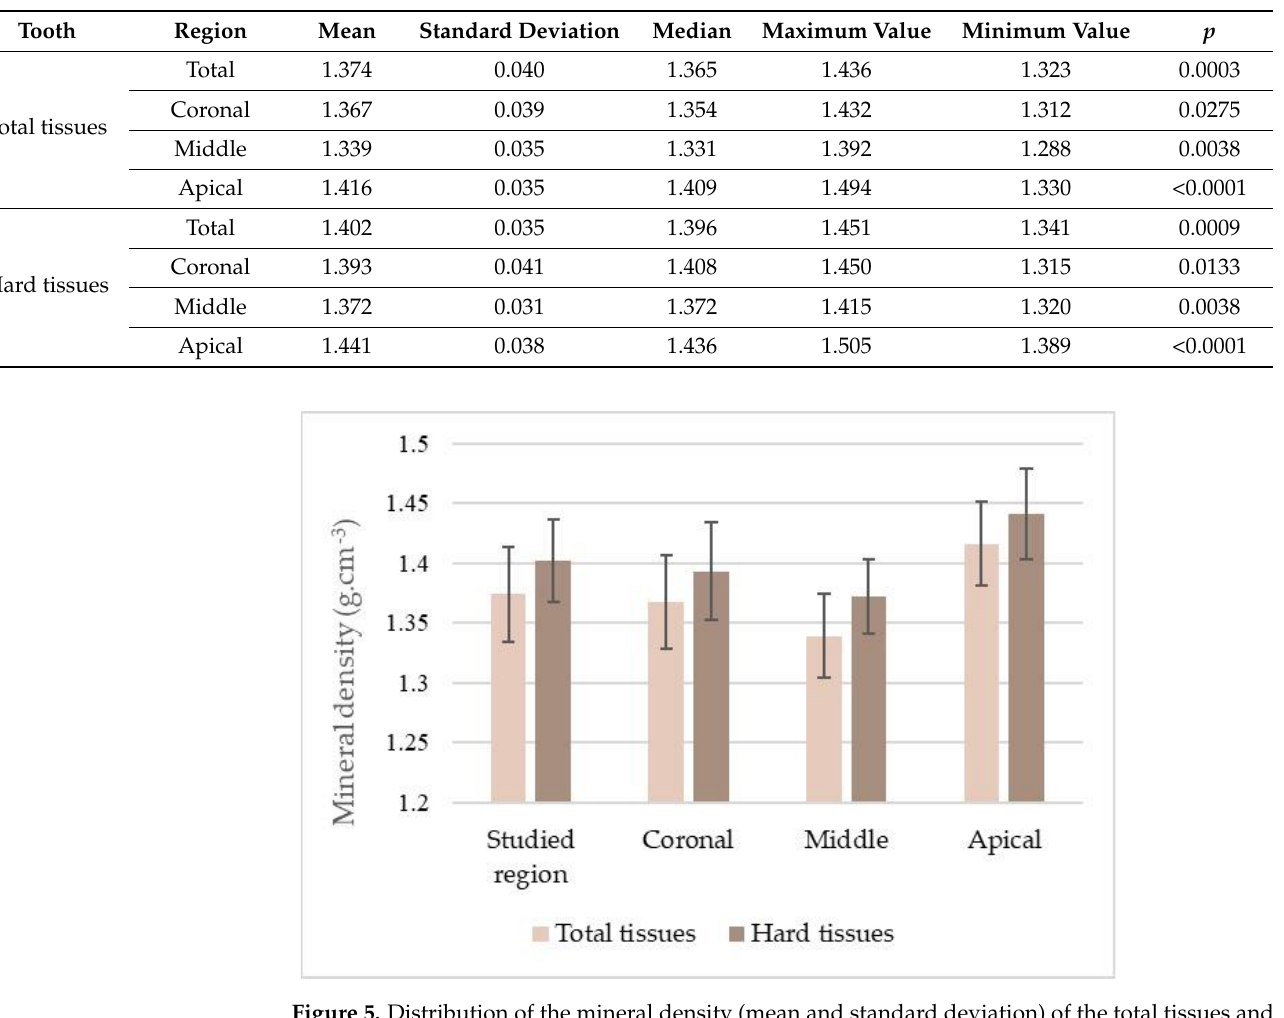
Figure 5. Distribution of the mineral density (mean and standard deviation) of the total tissues and hard tissues of the studied region of the tooth and its thirds.